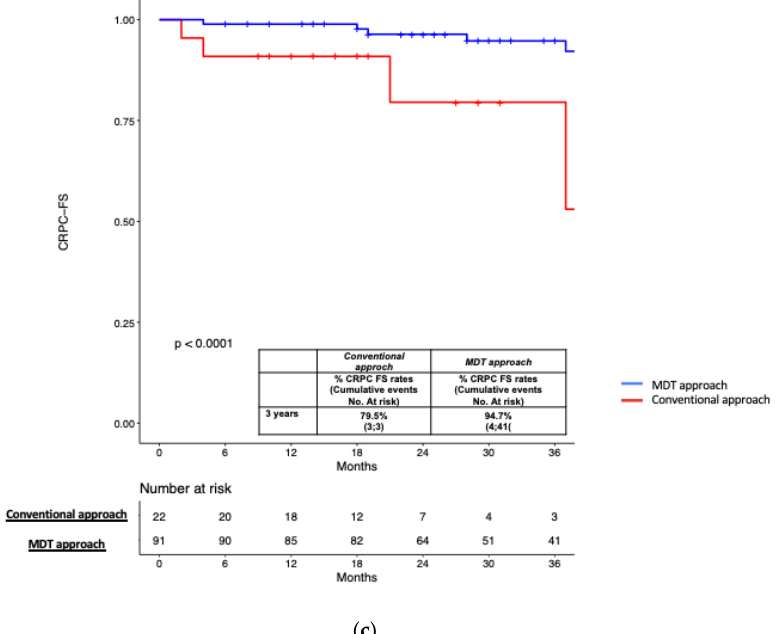
Figure 3. ( a ) Kaplan-Meier curve depicting Progression Free Survival (PFS) rates in the overall population (n = 113) according to type of treatment performed (MDT approach vs. conventional approach); ( b ) Kaplan-Meier curve depicting Metastases Free Survival (MPFS) rates in the overall population (n = 113) according to type of treatment performed (MDT approach vs. conventional approach); ( c ) Kaplan-Meier curve depicting Castration Resistant Prostate Cancer Free Survival (CRPC-FS) rates in the overall population (n = 113) according to type of treatment performed (MDT approach vs. conventional approach). In patients who underwent MDT, no significant differences were found for PFS and MFS estimates stratifying the population according to N1 vs. M1a-b disease (38.9% vs. 46.1% and 77.4% vs. 67% at 3 years; p ≥ 0.7; Figure 4a,b). However, the CRPC-FS estimates at 3 years were significantly higher in patients with N1 vs. M1a-b localization (100% vs. 86.1%; p = 0.02; Figure 4c).